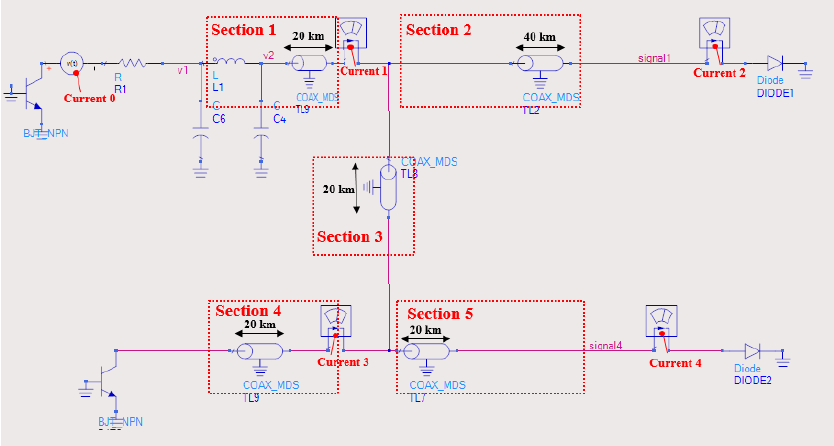
Figure 8. Equivalent circuit modeling of multi-terminal high-voltage direct-current (MTDC) system: scenario 1.